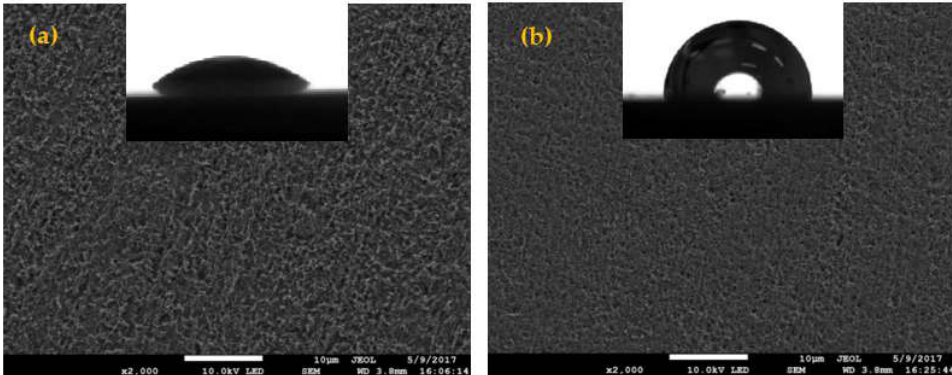
Figure 5. SEM and contact angle morphologies of the copper specimen immersed in 3% NaCl with and without MTT at 298 K (( a ) the blank, ( b ) 5 mM MTT).